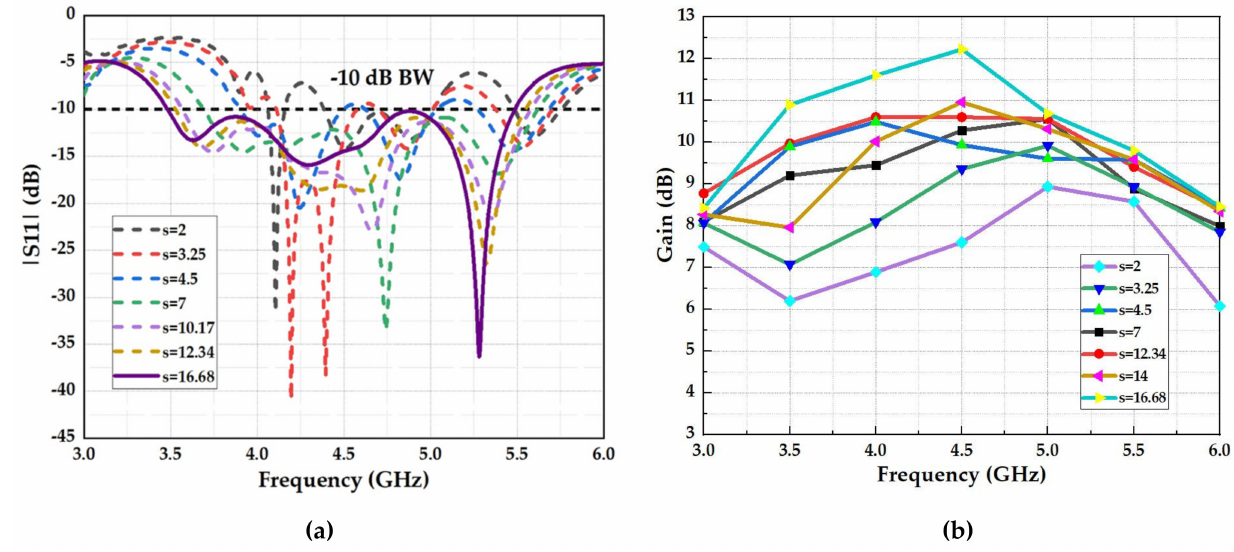
Figure 10. Simulated parametric study for the air gap between the array antenna and FSS reflector: ( a ) reflection coefficient (S11) and ( b ) realized